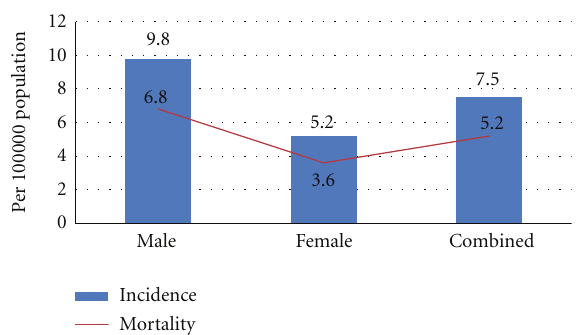
Figure 6: Incidence and mortality rates (age standardized) lip and oral cancer in India—by sex extracted from Globocan, 2008 data.